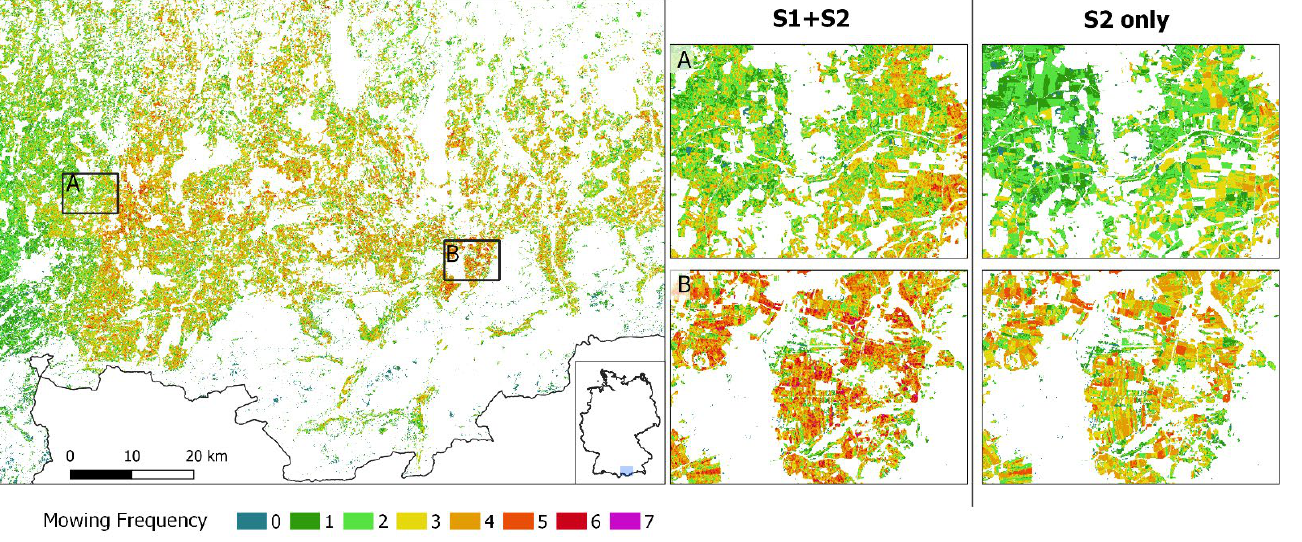
Figure 7. Mowing frequency derived from combined mowing detection approach of EVI and PolSAR entropy time series for the focus region and two zooms (A and B) with the frequency of the combined approach and only using S2.